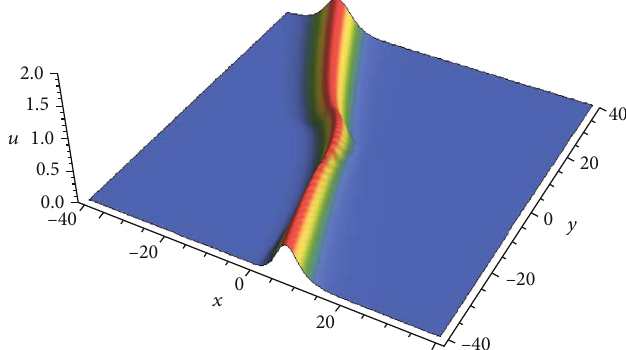
Figure 2: Fractional one-soliton u with α = 73/99 by selecting a = 1 , b = 2 , c = 3 , k